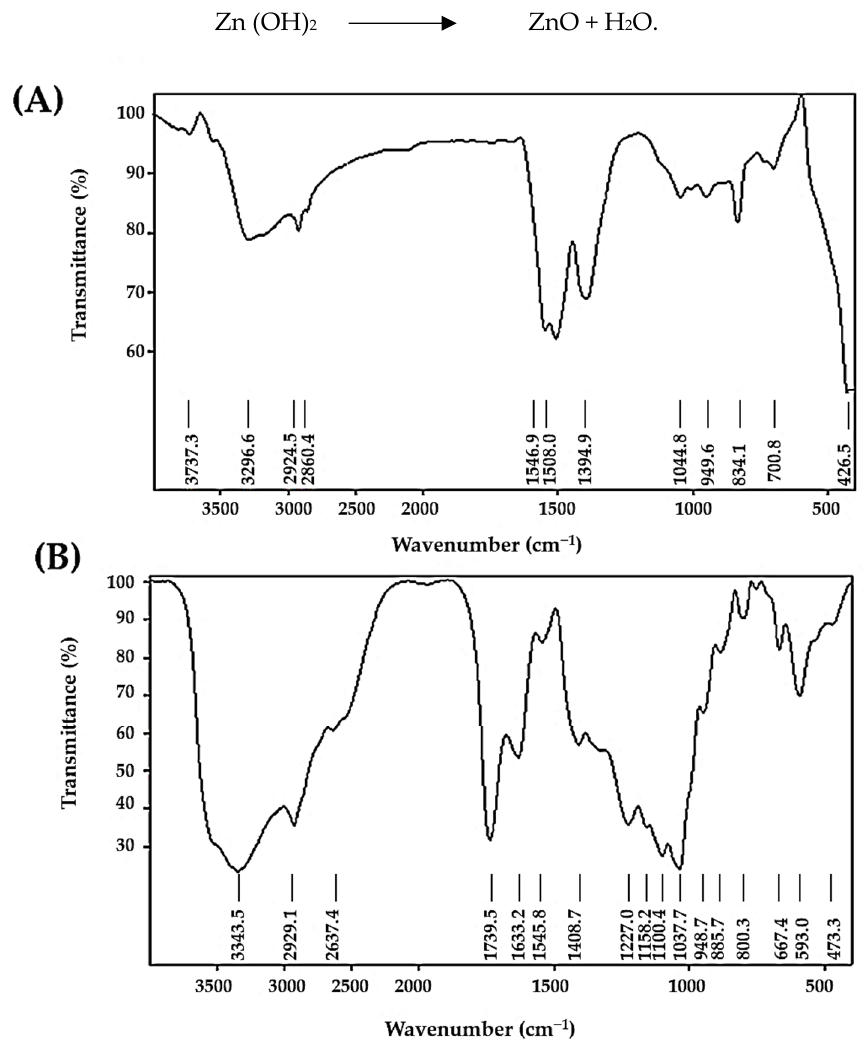
Figure 1. FTIR pattern of ZnO-NP before ( A ) and after adsorption of IV2R dye ( B ).